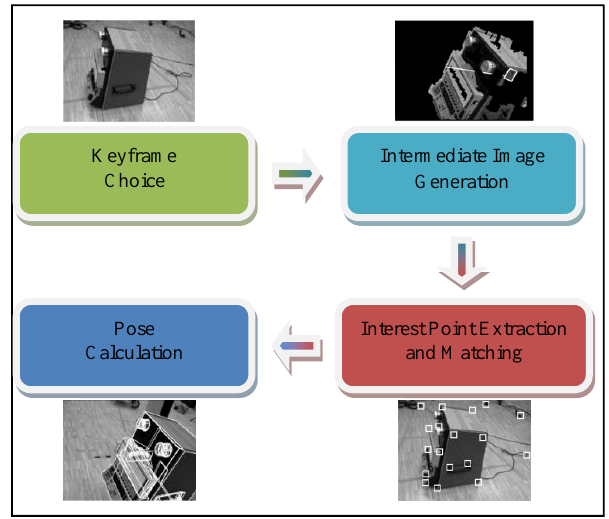
Figure 10. IPB technique workflow